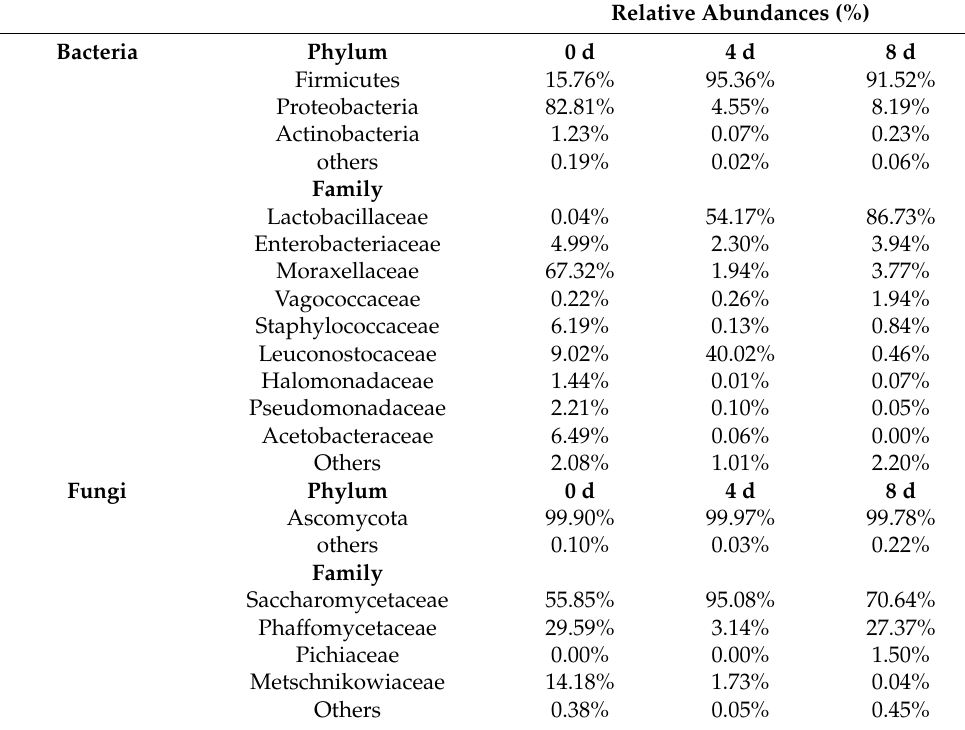
Table 4. Relative abundances of bacterial and fungal Phylum and Family levels (16 S) at different stages of